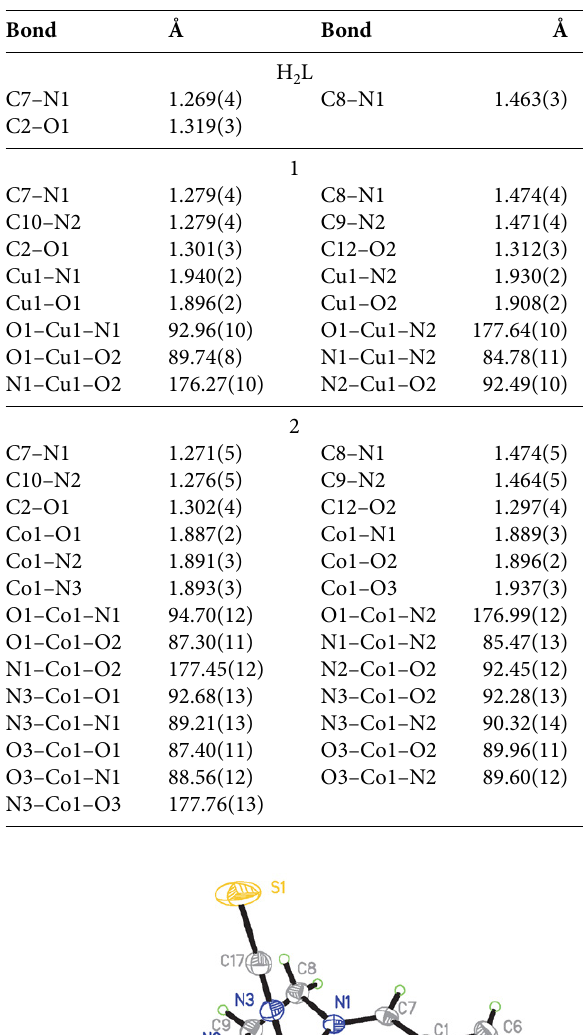
Table 2. Selected bond distances (Å) and angles (º) for the com- pounds Bond Å